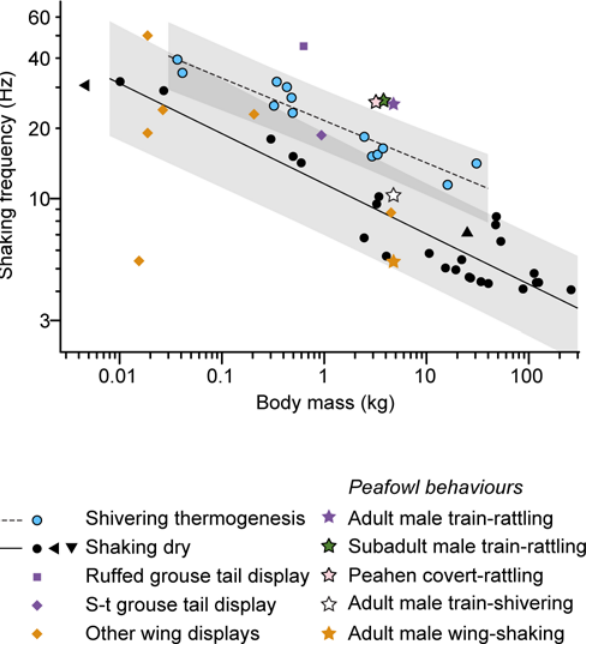
Fig 2. The average feather-shaking frequency of the peacock ’ s train-rattling display is above the predictions for an animal the mass of a peacock shivering and shaking dry, respecitvely. The mean values for peafowl behaviors are denoted with stars. Lines indicate fitted power law models derived in allometric studies of other shaking behaviors (Kleinebeckel and Klugmann 1990) (Dickerson, Mills and Hu 2012) with shaded 95% confidence intervals for the predicted values. For shivering, log 10 (frequency) = 1.335 – 1.86 log 10 (body mass), and for shaking dry, log 10 (frequency) = 1.063 – 0.215 log 10 (body mass). Circles are data from mammals used to calculate the scaling relationships for shivering and shaking dry. Black triangles are mean frequencies for hummingbirds (triangle pointing left) and seals (triangle pointing down) shaking dry. Orange and purple symbols are mean frequencies for courtship displays of other bird species (note that “ S-t grouse ” is the sharp-tailed grouse). Data sources are listed in S2 Text.